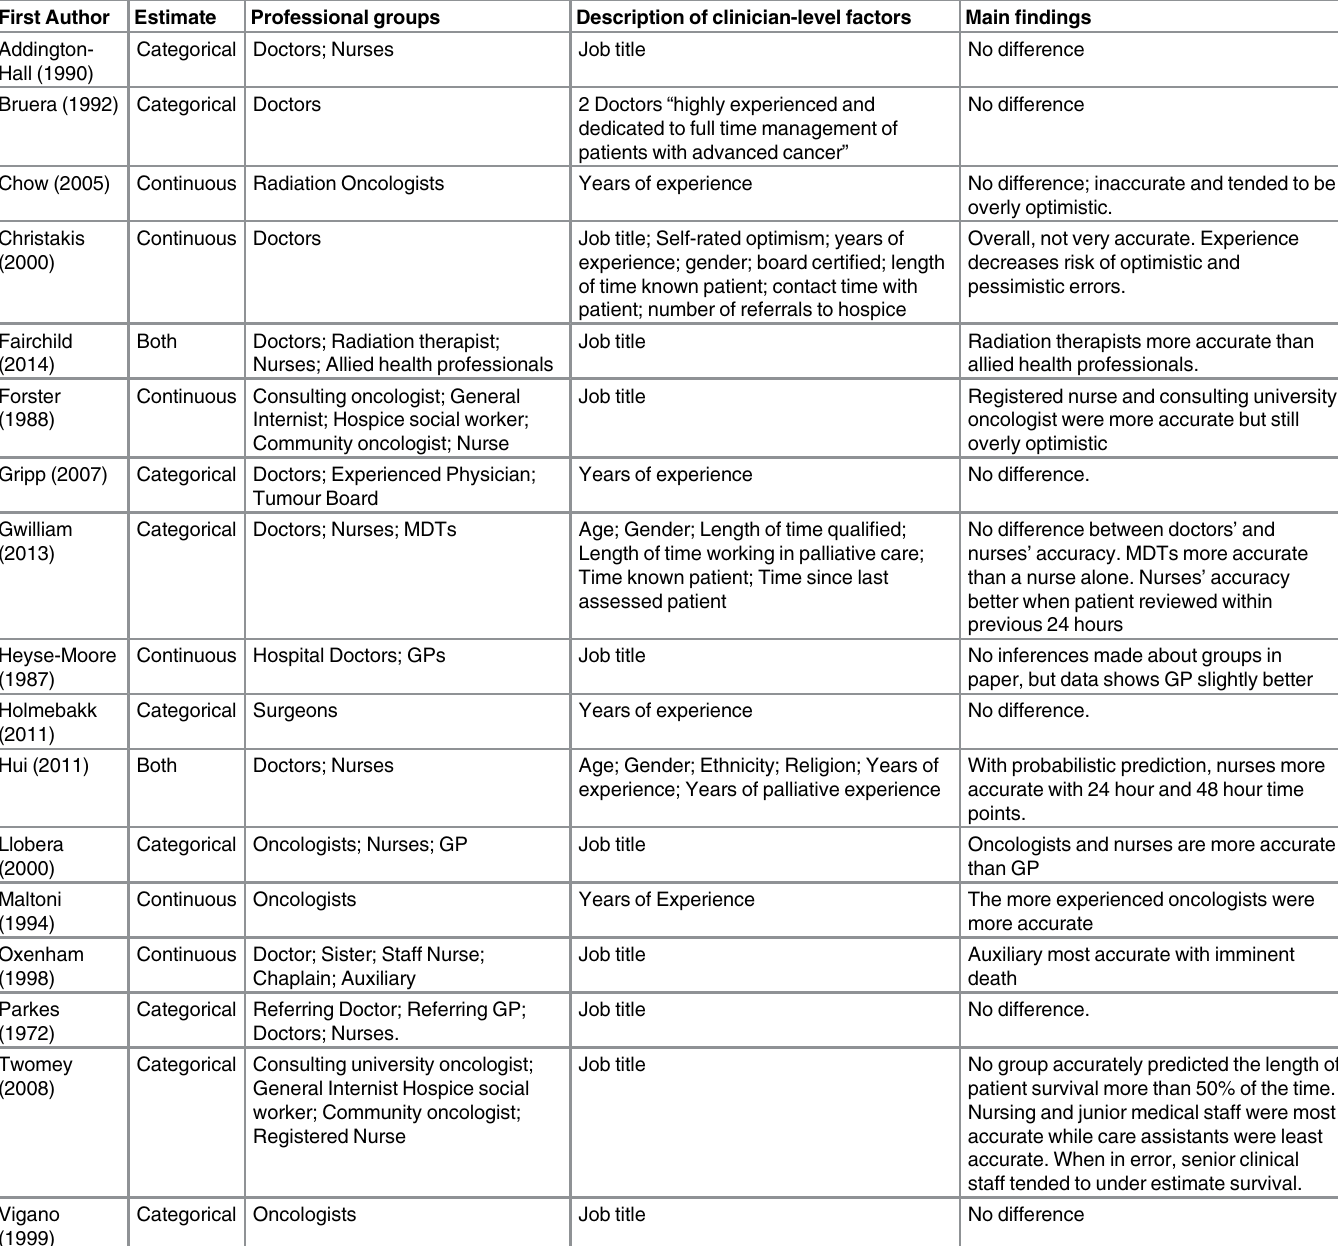
Table 4. Summary of studies investigating differences in prognostic accuracy between clinical